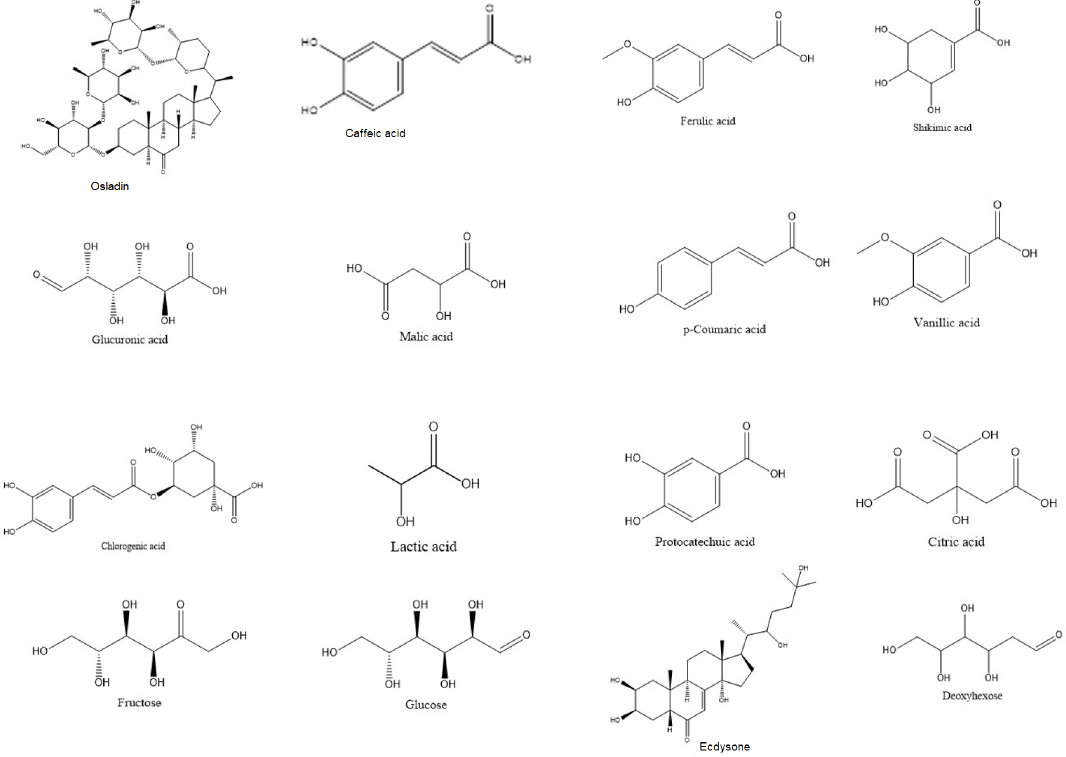
Figure 1. Chemical